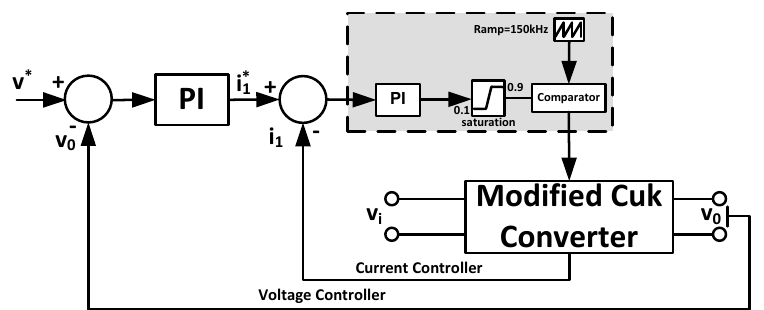
Figure 12. Comparison controller structure.